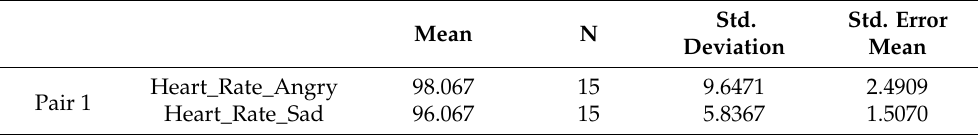
Table 13. Paired samples statistics for heart rate (angry to sad state).